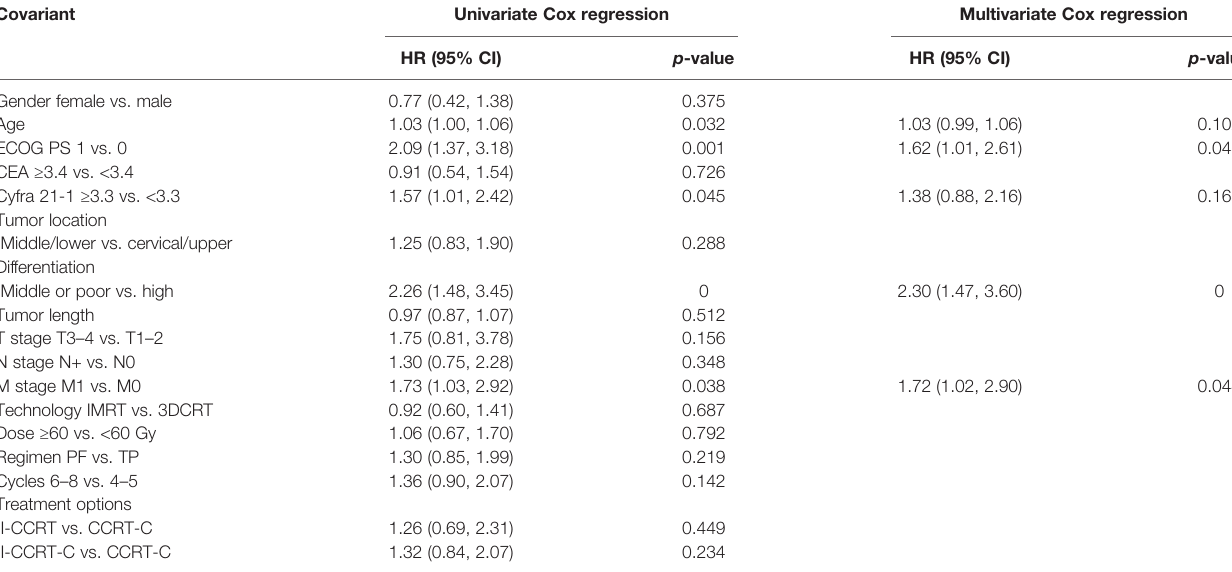
TABLE 3 | Univariate and multivariate Cox regression of prognostic factors for PFS. Covariant Univariate Cox regression Multivariate Cox regression HR (95% CI) p -value HR (95% CI) p -value Gender female vs. male